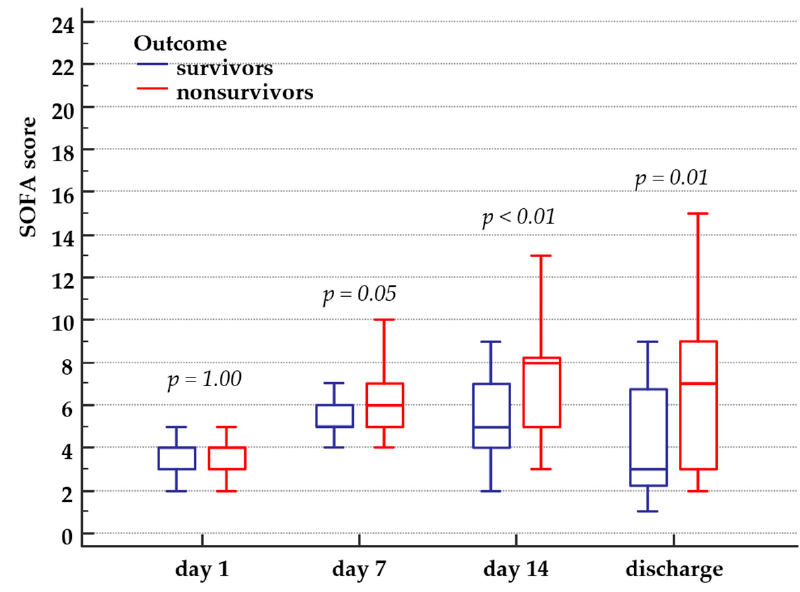
Figure 4. SOFA score in survivors and nonsurvivors. SOFA score minimum and maximum value, interquartile range and median value in survivors and nonsurvivors, from ICU day 1 until hospital discharge or in-hospital death.